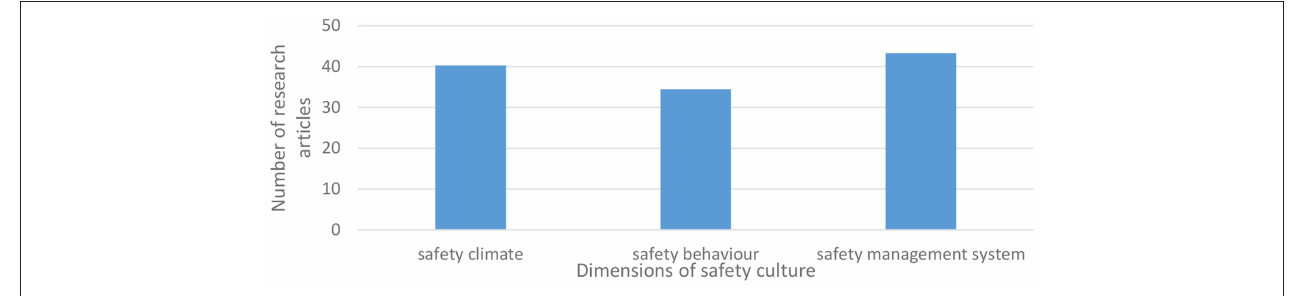
FIGURE 1 | Number of research articles by dimensions of safety culture.